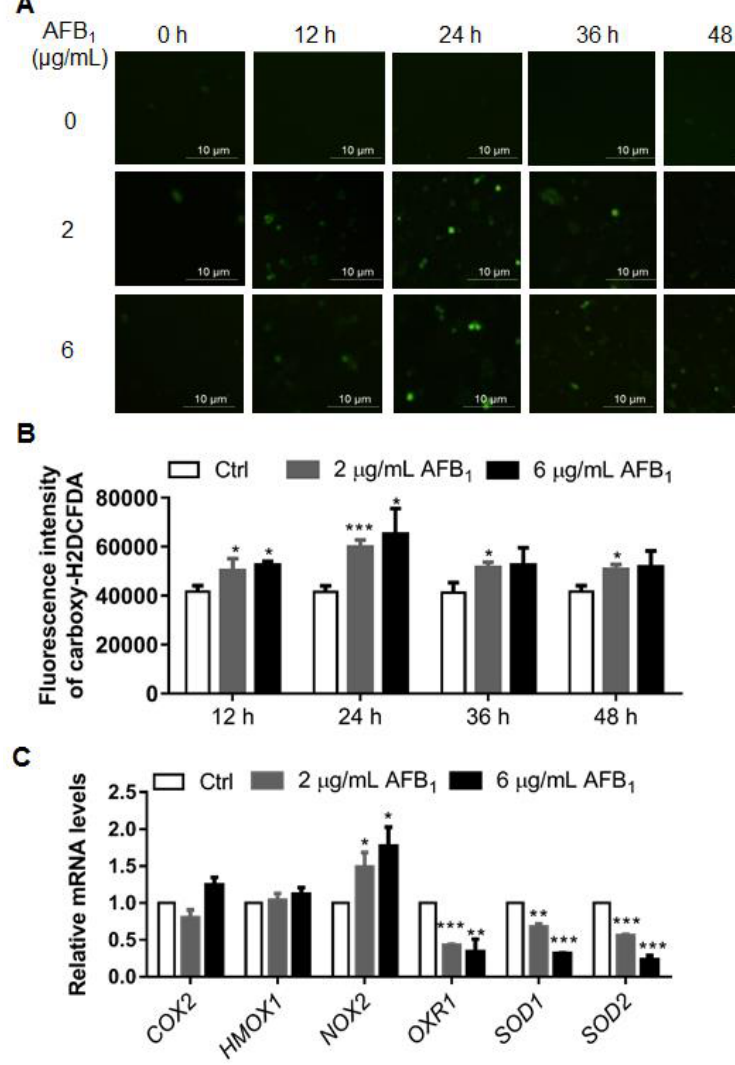
Figure 3. AFB 1 enhances intracellular ROS levels and inhibits the transcription of antioxidative stress-associated genes in IMR-32 cells. ( A ) ROS levels were detected by a carboxy-H2DCFDA probe (Green colour) and observed under a fluorescence microscope. ( B ) ROS production in IMR-32 cells after AFB 1 exposure was analyzed by flow cytometry after staining with carboxy-H2DCFDA; the data were analyzed using Flow Jo software (BD, Franklin Lakes, USA). ( C ) The mRNA levels of ROS-related genes in IMR-32 cells were analyzed using qRT-PCR after exposure to 2 μg/mL or 6 μg/mL AFB 1 . All the mRNA levels tested were normalized using the mRNA levels of GAPDH as the internal control. All experiments were performed in triplicate and the values represent the mean ± SD of three independent experiments. Statistical significance was defined as * p < 0.05, ** p < 0.01, or *** p < 0.001.